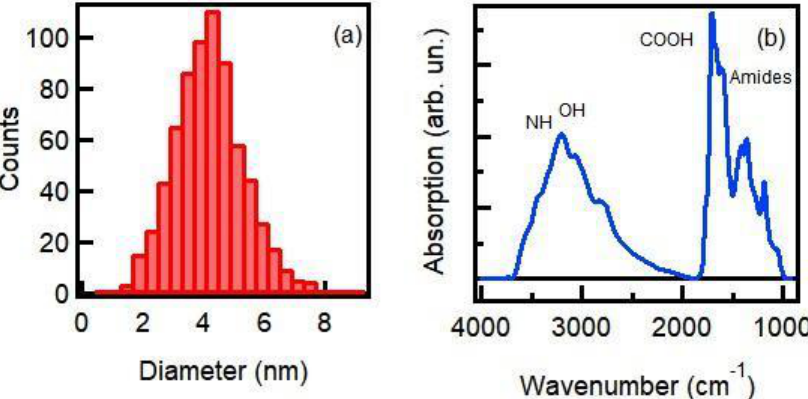
Figure 1. ( a ) Size distribution of C-dots from atomic force microscopy (AFM) measurements. ( b ) Infrared absorption spectrum of C-dots. The labels point out the attributions that we propose for the absorption peaks. The vibrational signals are associated to amide (1670–1600 cm −1 ), carboxylic groups (1700 cm −1 ) and hydroxyl groups (3200 cm −1 ), which cover C-dots surfaces.